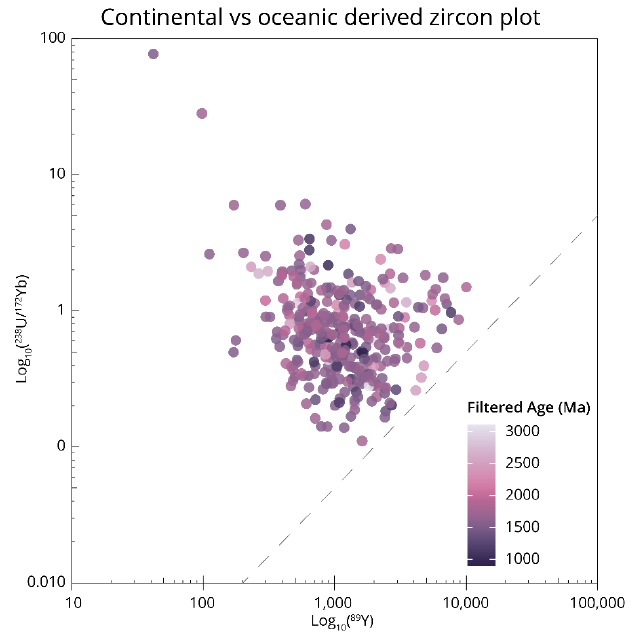
Figure 8. Plot based on [112] used as an indicator of zircon crustal origin. This plots Y against U/Yb, with the dashed reference line dividing the “oceanic” (below line) and “continental” (above line) fields. All data plotted above the reference line, suggesting zircon formation in the crust of continental affinity. Coloured by filtered age, where light is older and darker is younger.